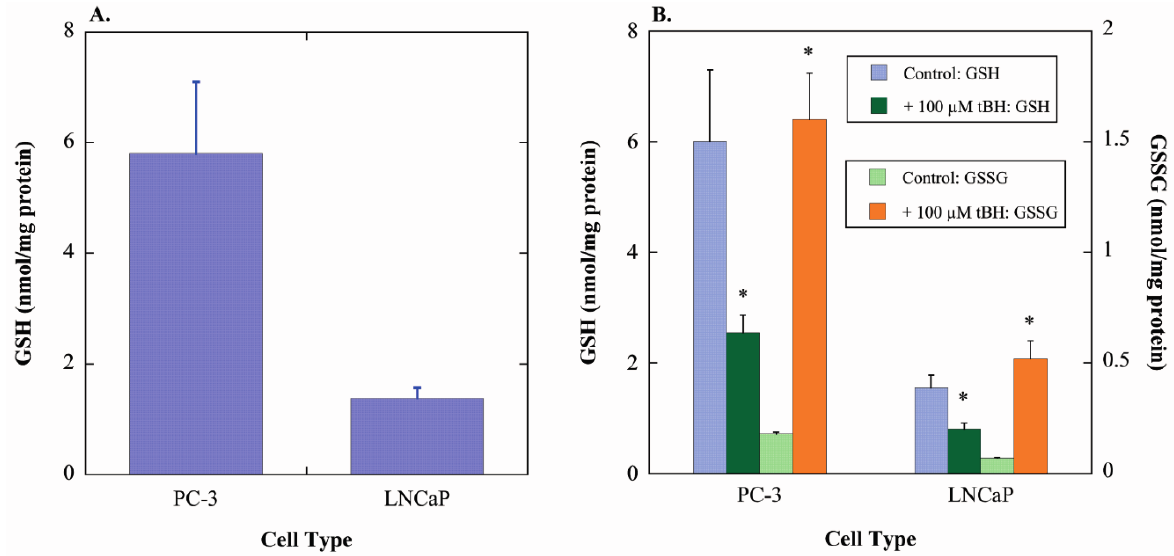
Figure 1. GSH content and oxidant-induced GSH oxidation in PC-3 and LNCaP cells. ( A ) GSH was measured in total cell extracts by the GSH Glo™ Glutathione Assay kit,